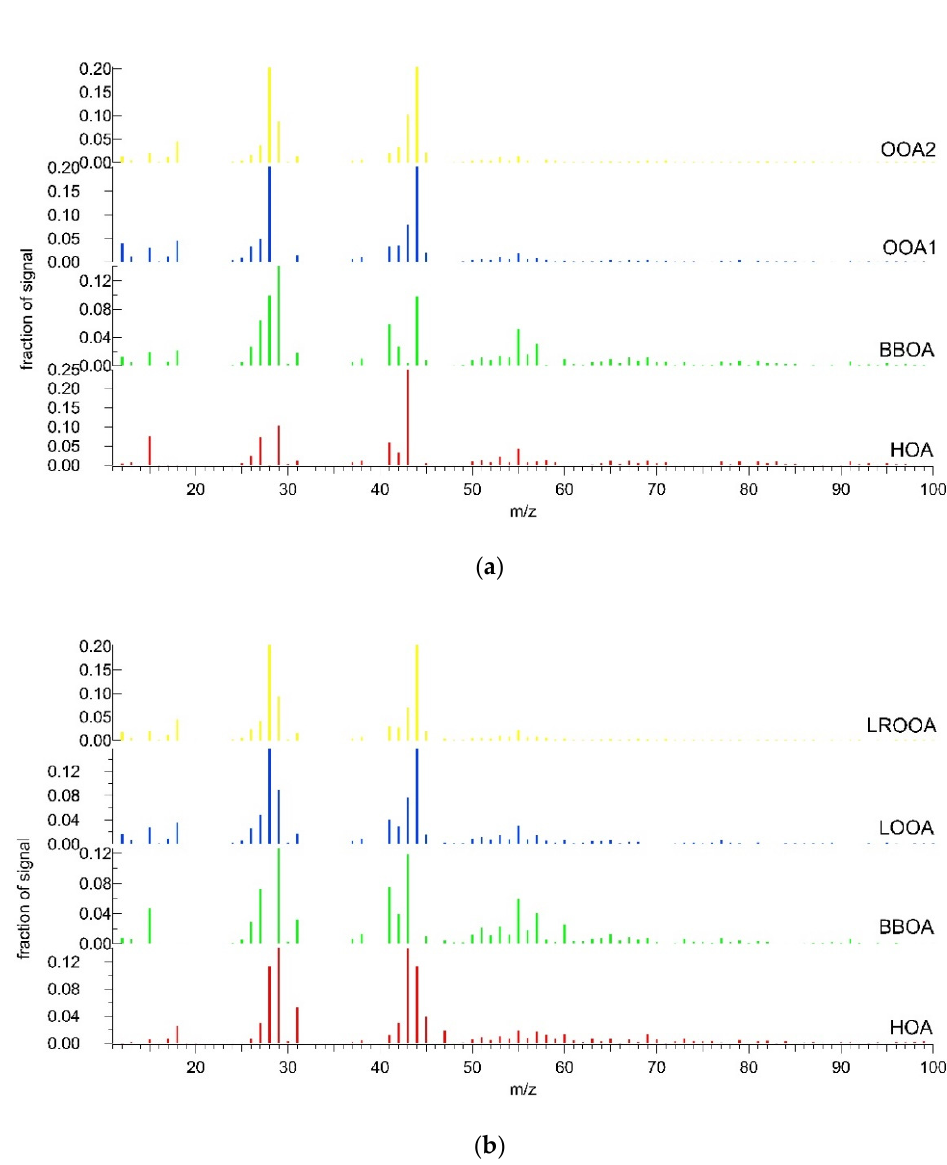
Figure 2. Factor profiles obtained by analysis of organic part of mass spectra from ( a ) summer campaign and ( b ) winter campaign.